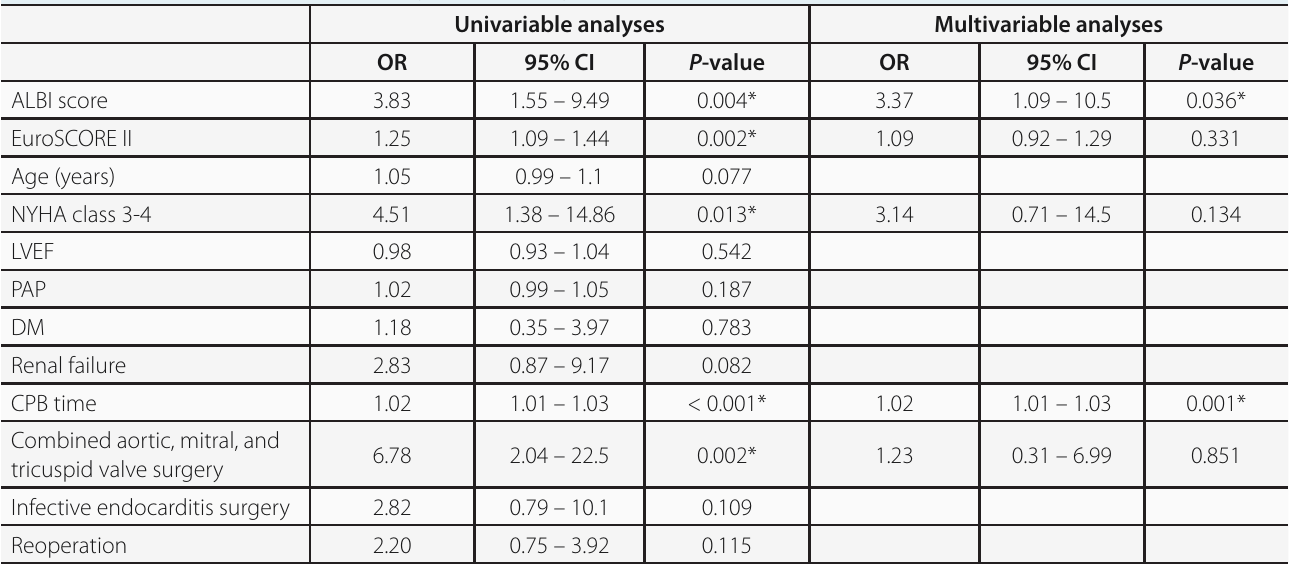
Table 4. Univariable and multivariable analyses of mortality.